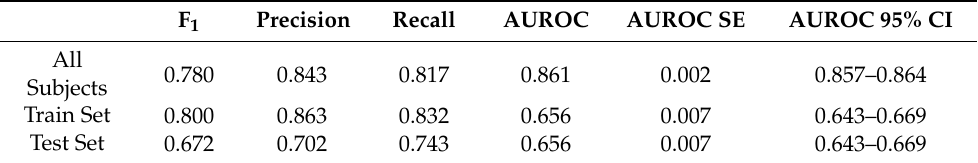
Table 5. The evaluation metrics of the random forest classification model for mortality.